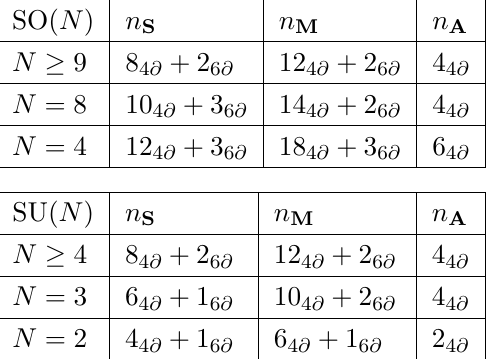
Table 10 . The number of generators of M inv in D ≥ 8 . We have indicated the S 3 representation and the derivative order of all the generators. The counting for SO( N ) with N = 7 , 6 , 5 is the same as that for N ≥ 9